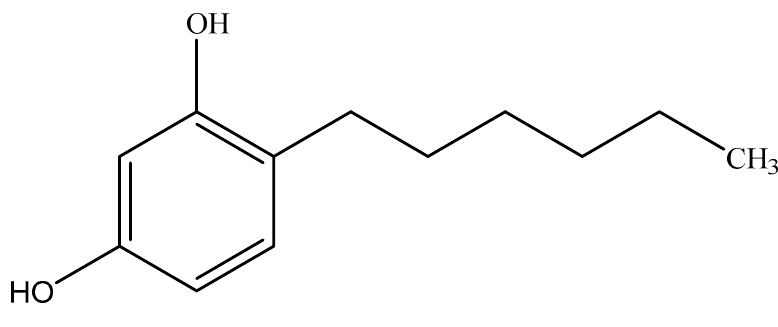
Figure 1. Structure of 4-hexylresorcinol.